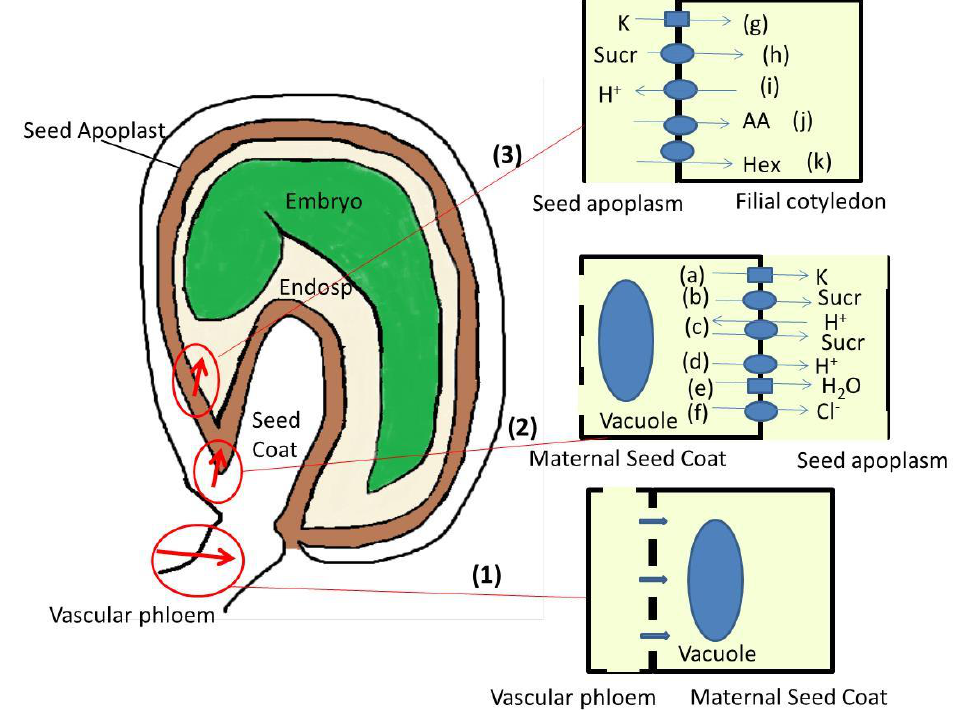
Figure 1. (1) Cellular efflux of phloem-imported nutrients to the maternal seed coat occurred through the plasmodesmata. (2) Nutrient transport from the maternal seed coat to the seed apoplasm involves different transporters situated in the plasma membrane as a) non-selective channel; (b, c) sucrose/H+ carriers and symporters; (d) H+-ATPase; (e) aquaporins; (f) Cl − channel and finally (3) Nutrient transport from the seed apoplast to the plasma membrane of cotyledons (embryo and endosperme tissues) involves transporter as (g) non-selective cation channel; (h) sucrose transporters (i) H + -ATPase; (j) amino acid transporters and (k) hexose transporters.